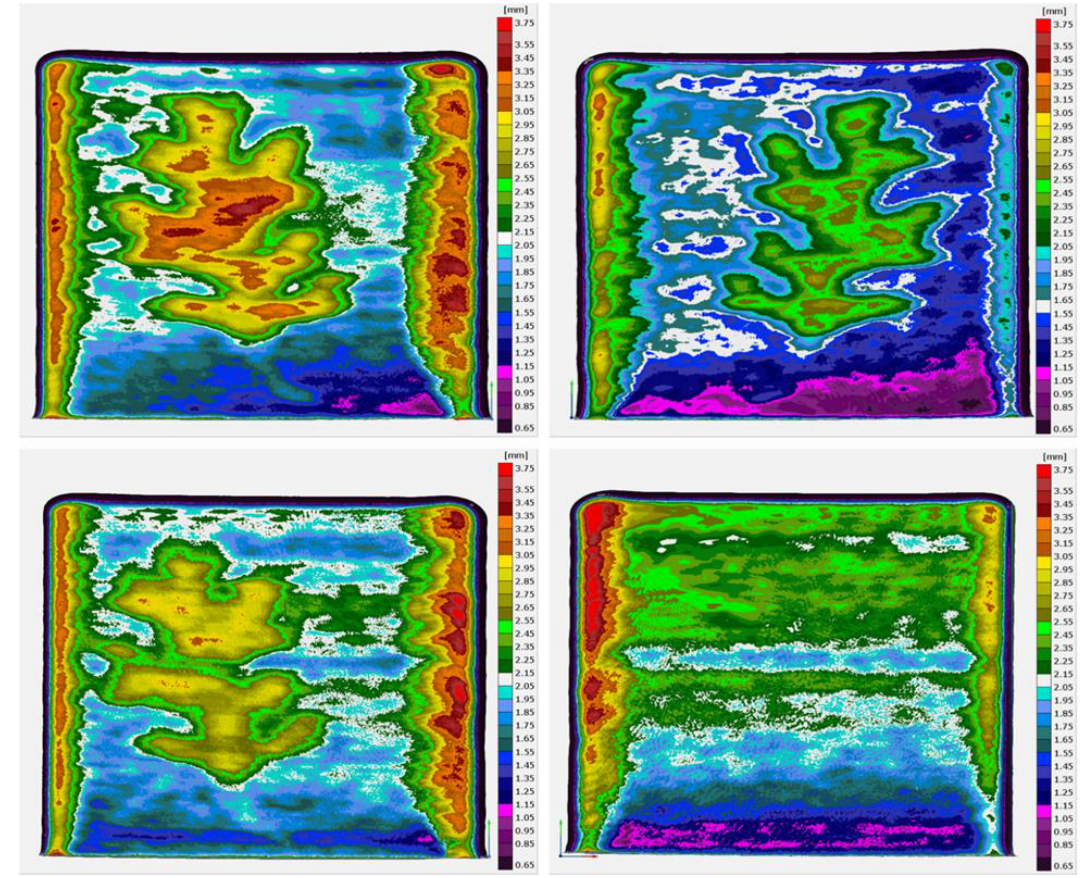
Figure 9. Wall geometry scans; Wall 2, side two ( top left ), Wall 2, side one ( top right ), Wall 1, side two ( bottom left ), Wall 1, side one ( bottom right ).